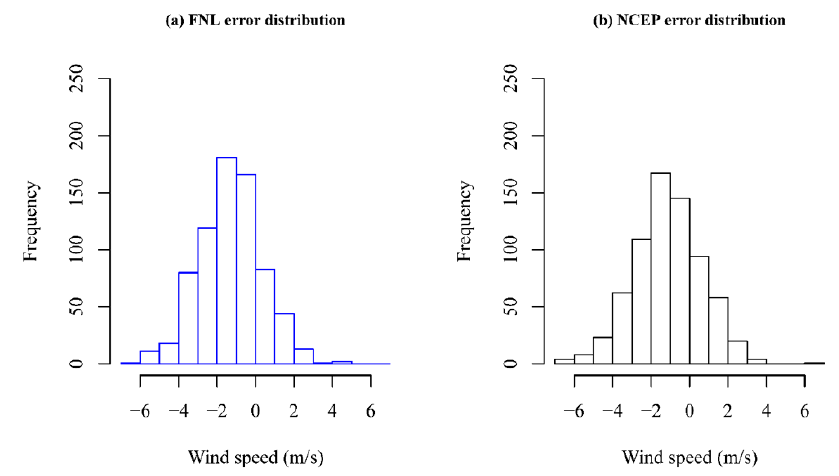
Figure 12. Wind speed error distributions at Crown Point for the 10 m height above ground.